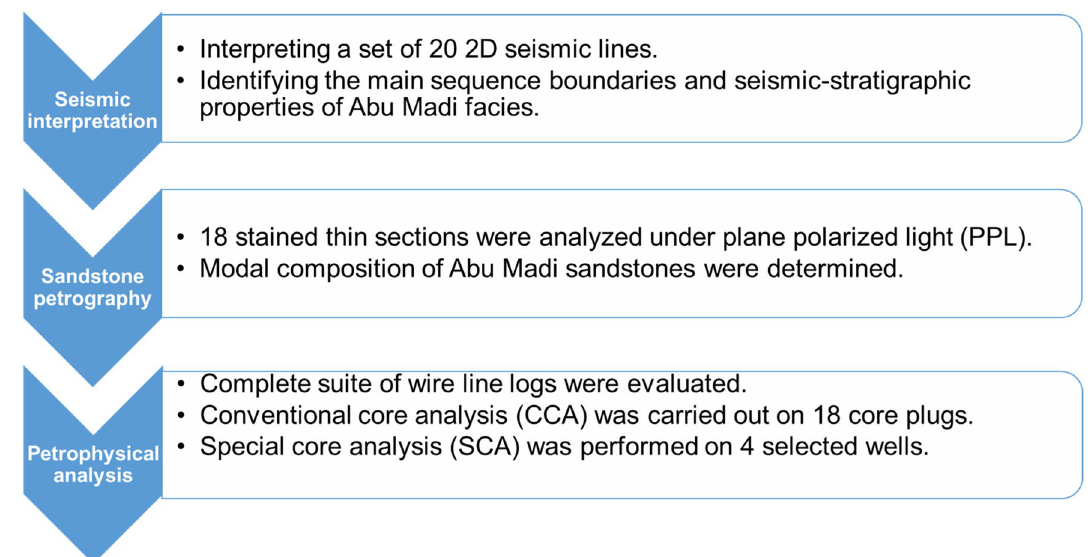
Fig. 3 Illustrative flowchart shows the stepwise procedure followed in this study for data analysis and